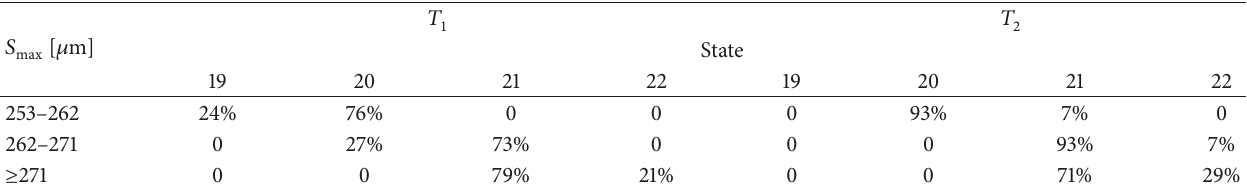
Table 6: Posteriori